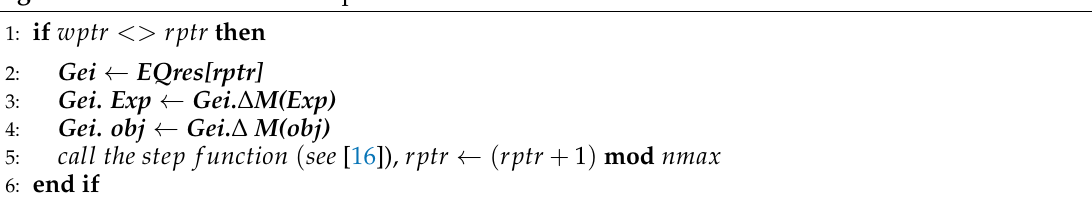
Algorithm 2 Discrete Event Output Function for GeFB.